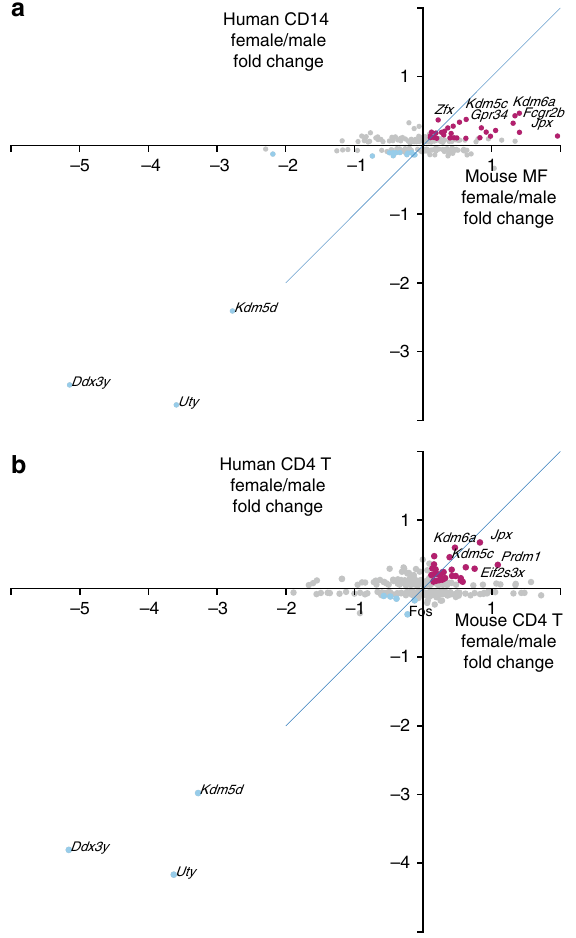
Fig. 7 Comparison of human and mouse transcriptional immune sexual dimorphism. Female – male fold change (log 2 ) of ImmVar genes that are differentially expressed between female and male in a human CD14 and mouse MF cells from dataset B, and b human CD4 and mouse T4 cells from dataset B. The colored genes have >0.1 (log 2 ) fold change in both datasets in females (pink) or males (light blue). Selected gene symbols are shown. Source data for a , b are provided as a Source Data fi